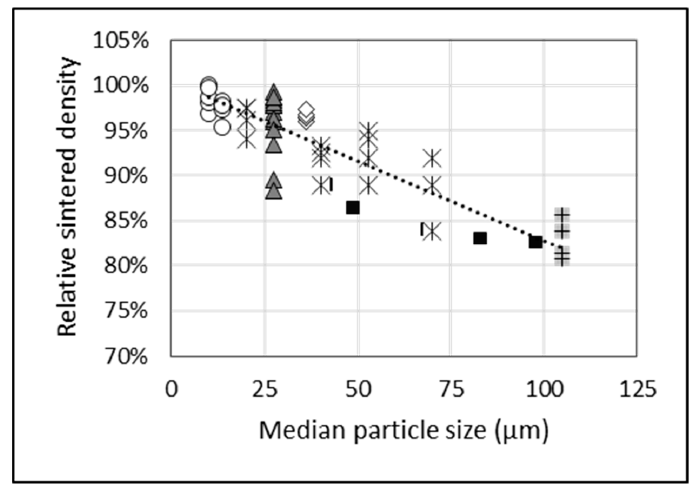
Figure 7. Relative sintered density versus median particle size for cold compacted titanium samples from HDH powder. Sintering temperature ≥ 1000 °C. Compaction pressure ≥ 200 MPa. Data from 6 sources, as indicated by the different symbols.